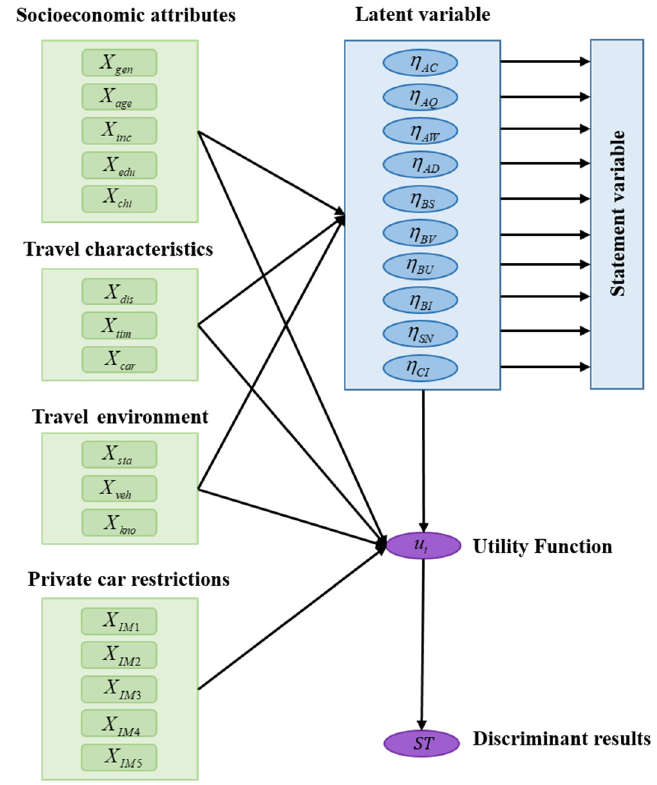
Figure 2. Illustration of the proposed mixed logit model.